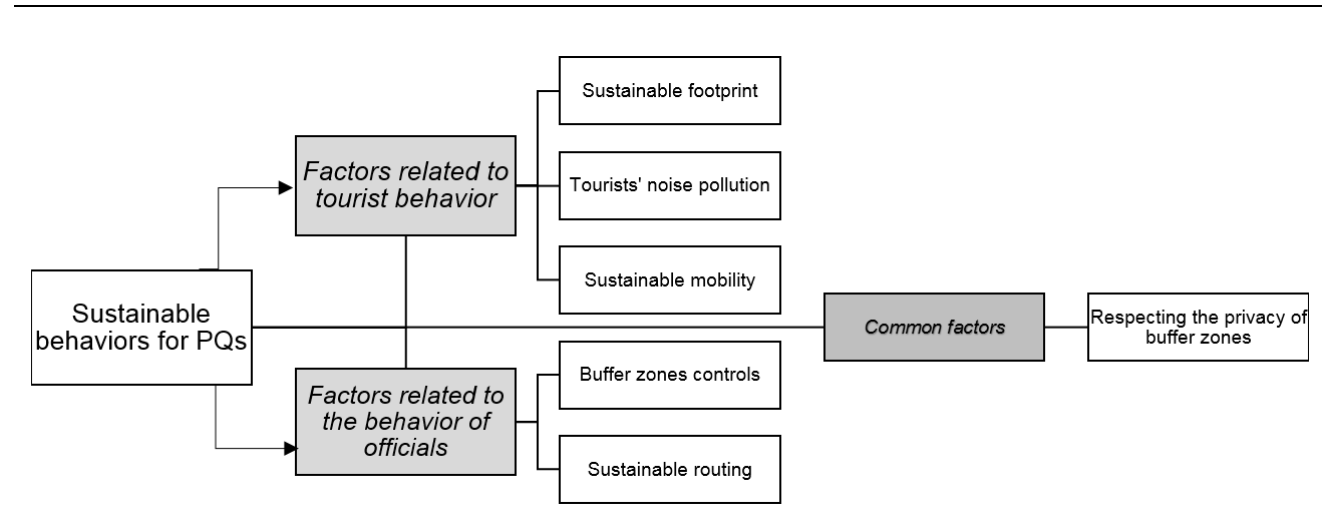
Figure 5. Sustainable behaviors model for PQs listed as UNESCO World Heritage property.